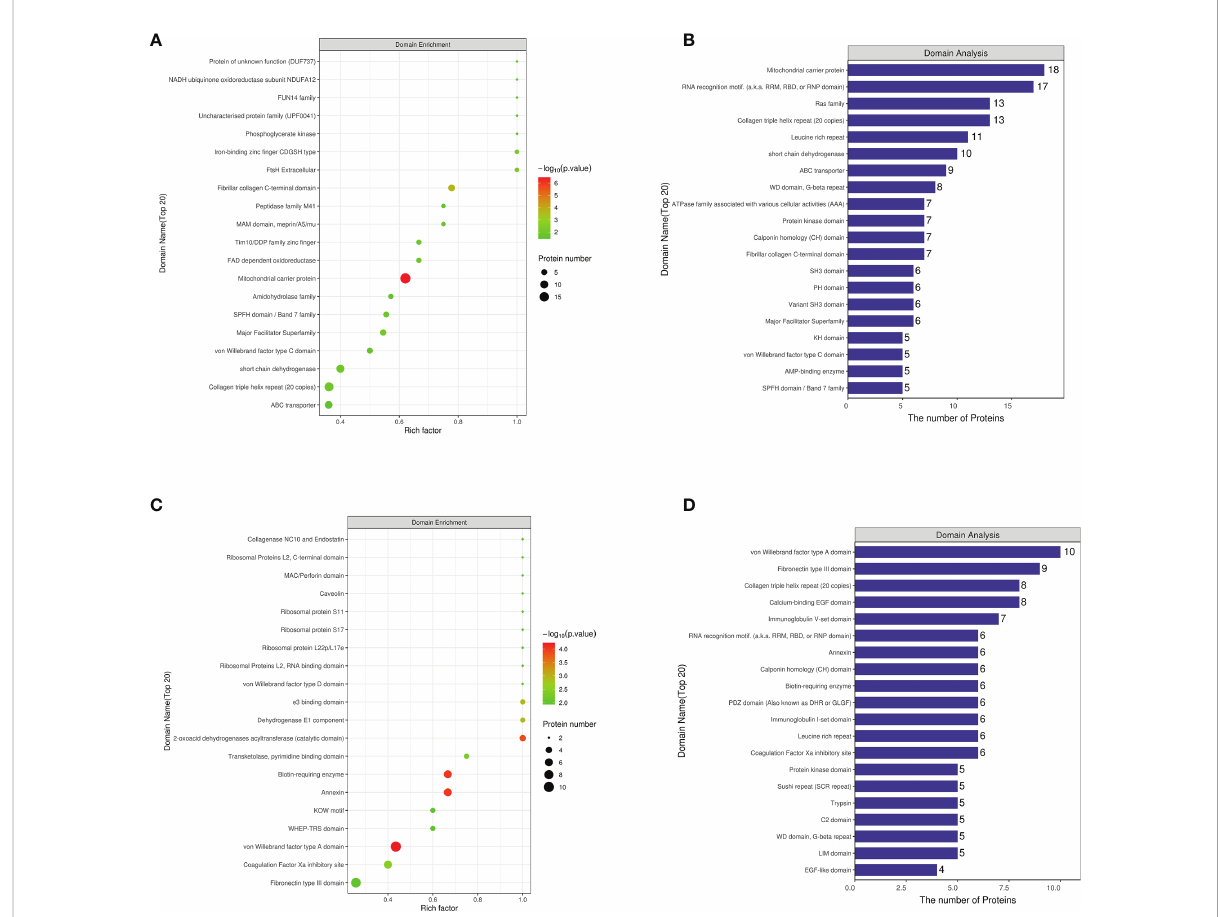
FIGURE 5 (A) The fi rst 20 regions where the enrichment factor accumulates in NCD/HFD. (B) The number of proteins in the fi rst 20 regions where enrichment factors are concentrated in NCD/HFD. (C) The fi rst 20 regions where the enrichment factor accumulates in HFD/Sema. (D) The number of proteins in the fi rst 20 regions where enrichment factors are concentrated in HFD/Sema.